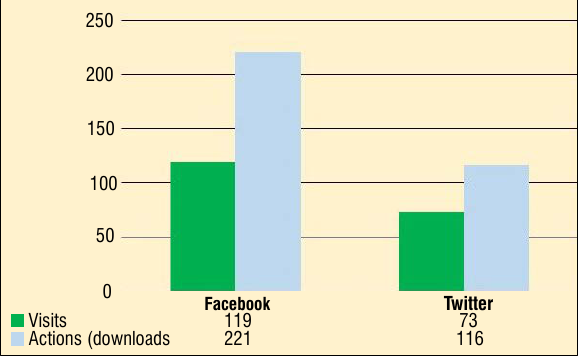
Figure 7: Visits to and actions on South African Journal of Libraries and Information Science social media,